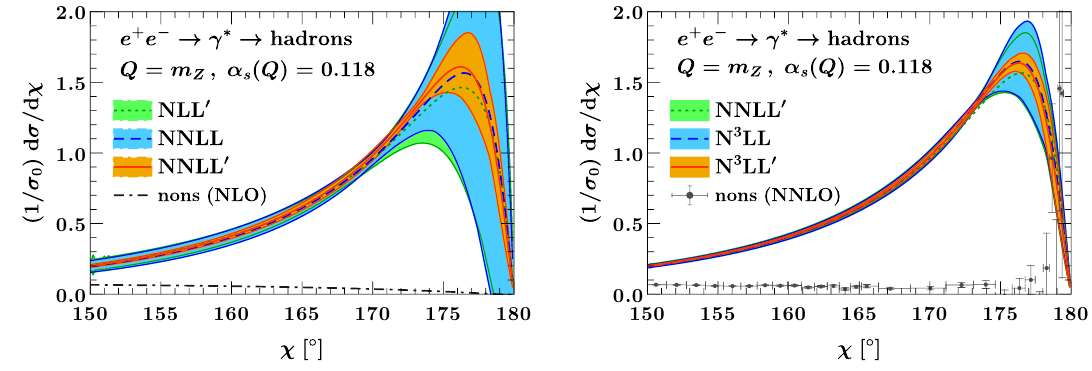
Figure 2 . Comparison of the resummed EEC spectrum as a function of the angle χ at different resummation orders. The shaded areas, bounded by the solid lines, show the individual uncertain- ties, with the central value indicated according to the legend.